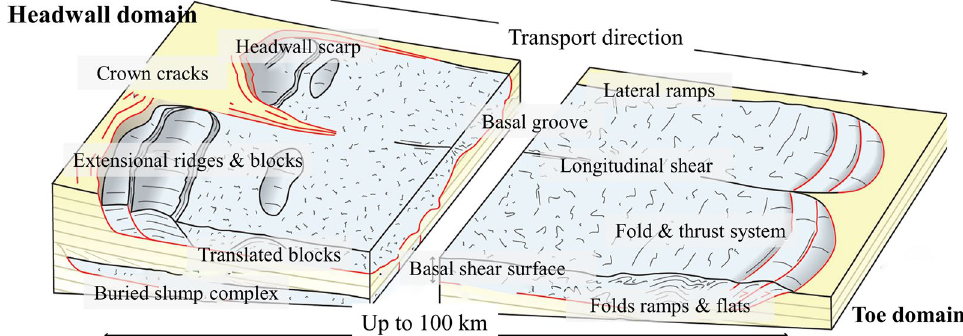
Fig. 15 Schematic illustration of the morphology and structures of a submarine landslide (modified from Scarselli